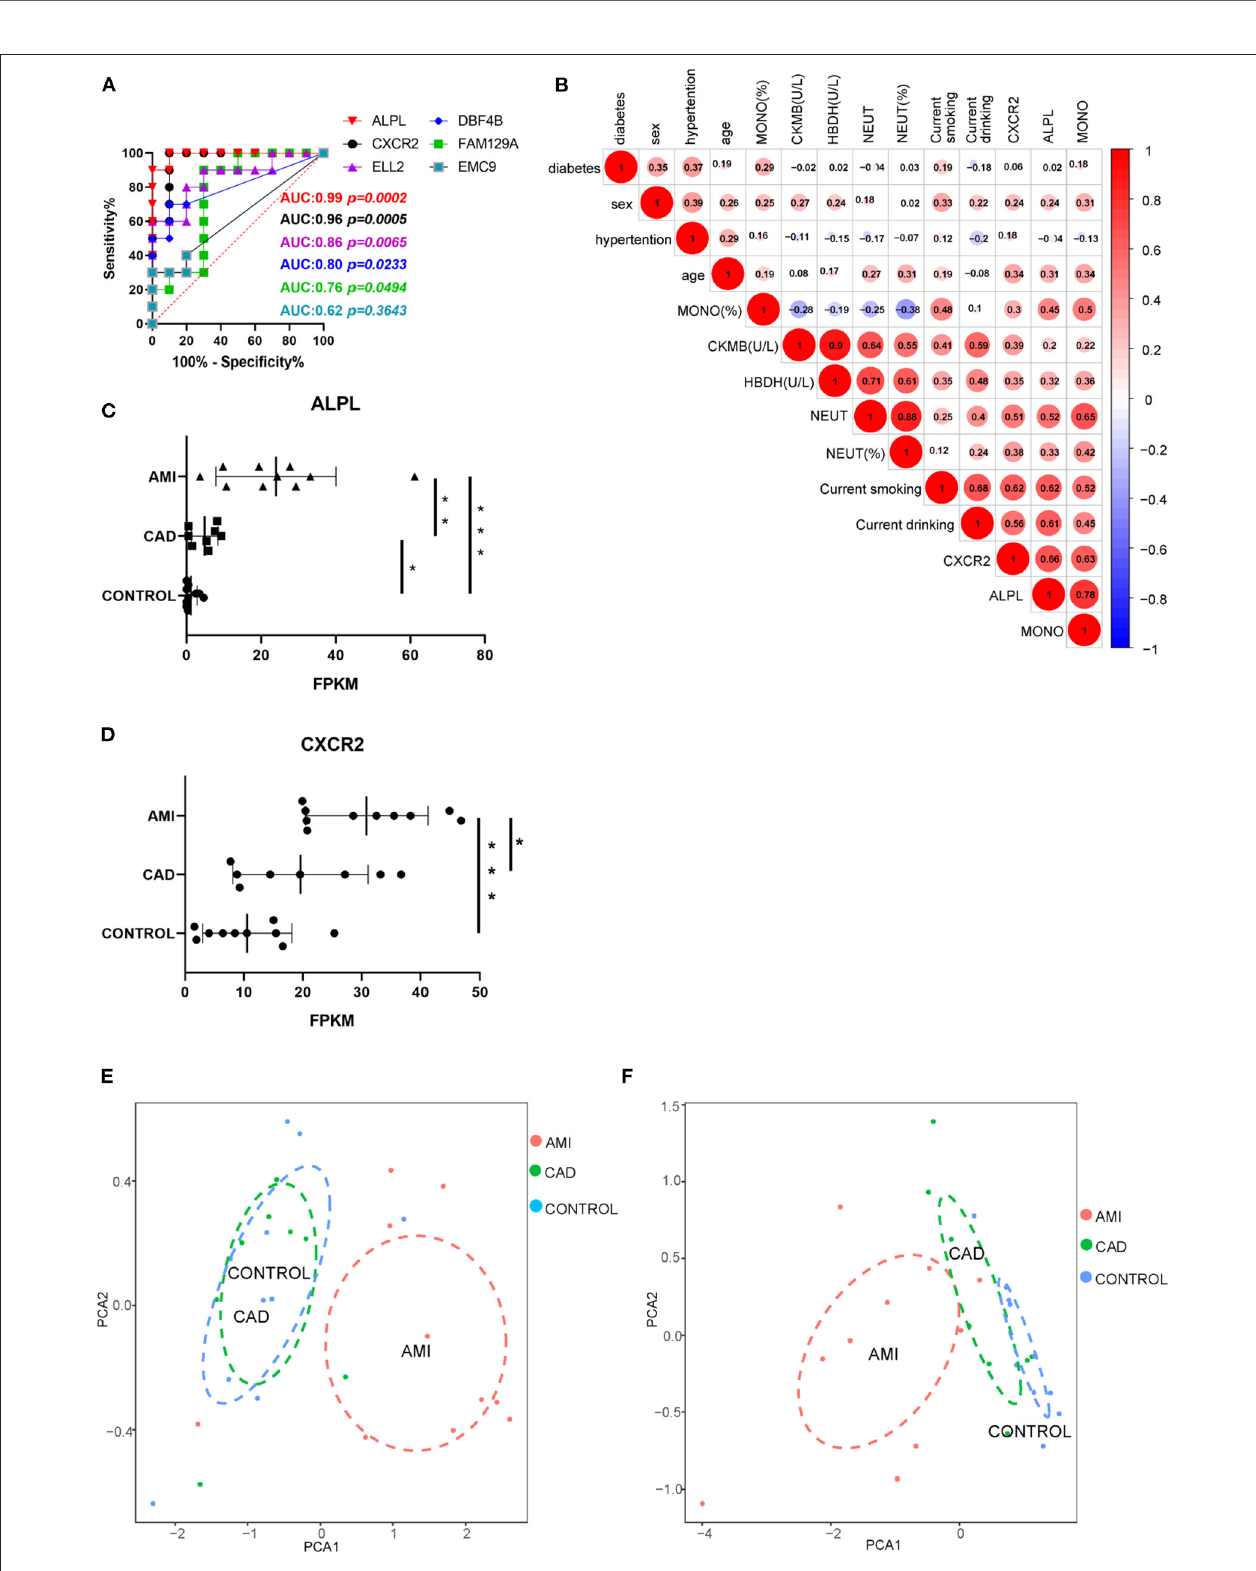
FIGURE 6 | Potential clinical value of ALPL and CXCR2. (A) The ROC curve analysis of six core exosomal mRNAs. (B) The correlation analysis between these two exosomal mRNAs and clinical baseline characteristics. (C,D) The statistical analysis of expression of ALPL and CXCR2 among AMI, CAD, and control group. Results are presented as the mean ± SD (* P < 0.05, ** P < 0.01, and *** P < 0.001). (E) PCA of neutrophil count and neutrophil ratio. (F) PCA of the expression of ALPL and CXCR2.